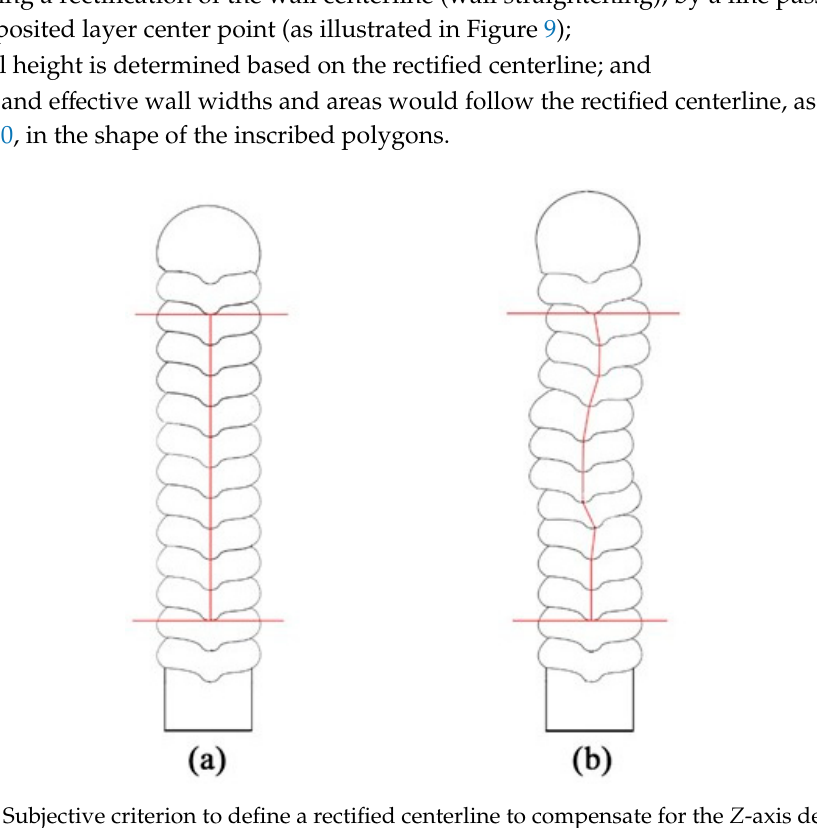
Figure 9. Subjective criterion to define a rectified centerline to compensate for the Z -axis deviations: ( a ) a straight wall; and ( b ) a distorted wall (overstated in relation to the actual walls to emphasize the differences).